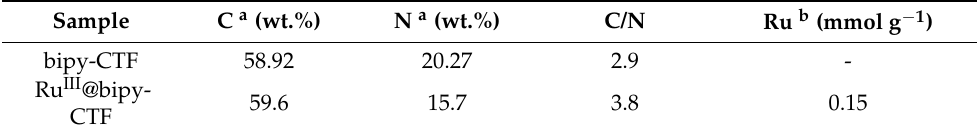
Table 1. Elemental analysis of the pristine and modified CTF